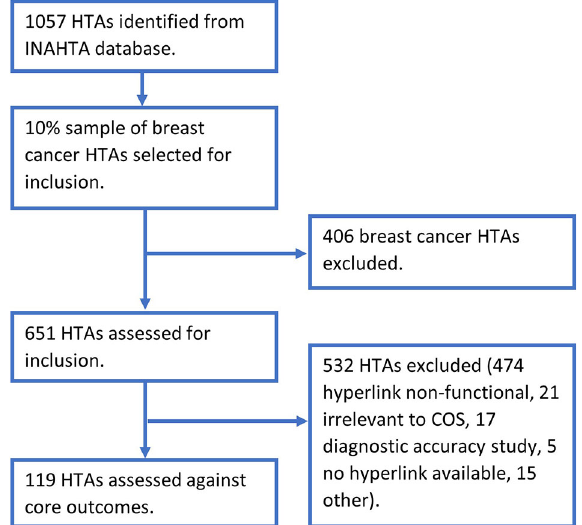
Figure 1. HTA identification and selection flowchart. COS, core outcome set; HTA, health technology